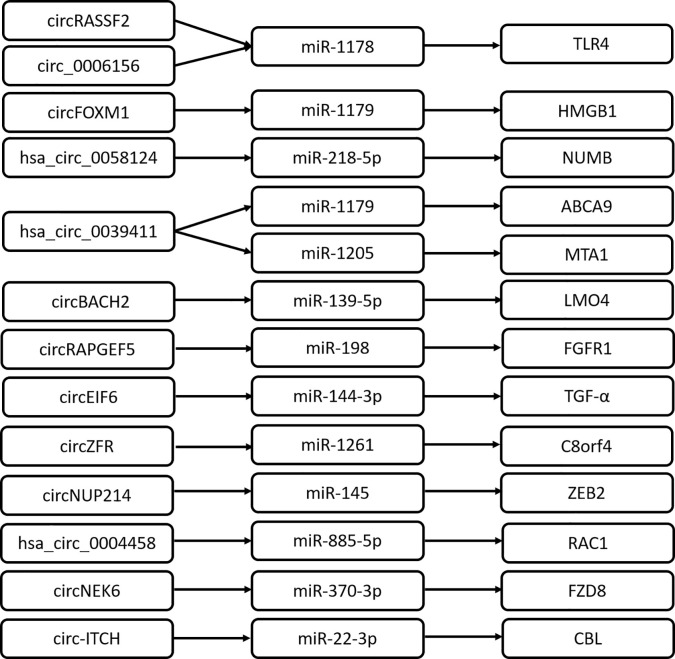
CircRNAs play roles by acting as ceRNA in PTC.